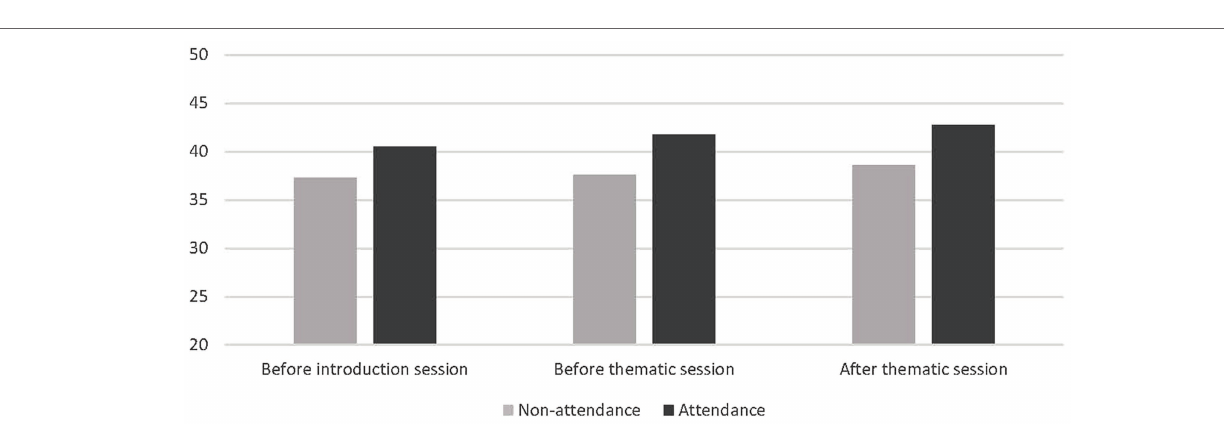
FIGURE 3 | Mean emotional wellbeing scores in Study 1 as a function of timing of measurement attendance (versus non-attendance) to a thematic session and practice afterward. Higher cores indicate greater emotional wellbeing. Scores could be from 8 (lowest) to 56